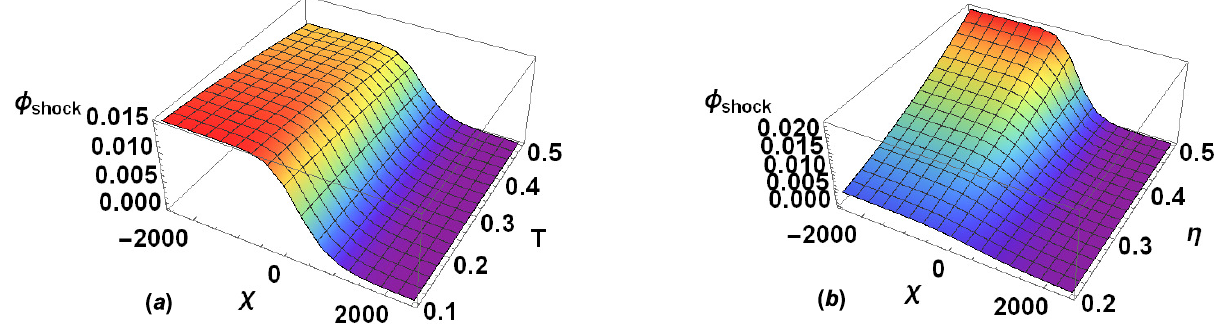
Figure 3. (Color online) Variation of Three-dimensional profile of shock wave for different values of ( a ) temperature degeneracy ( T ) ( b ) viscosity ( η ), with fixed values of l z = 0.6, µ b = 0.2, V b 0 = 0.4, γ b = 0.5, and H =